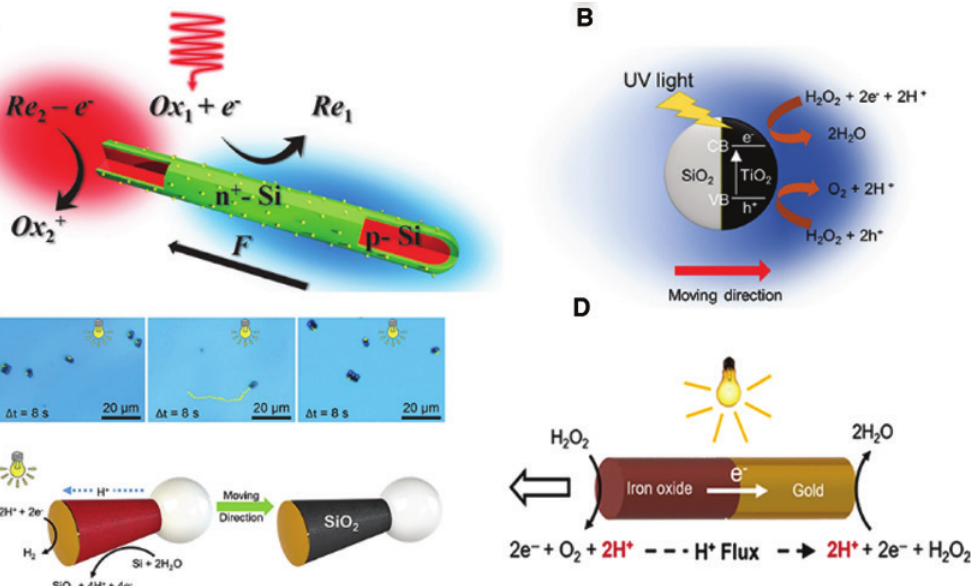
Figure 5: Micro/nanomotors with self-electrophoretic propulsion. (A) Working principle schematic of n + -Si/p-Si micromotor decorated with Pt nanoparticles [93]. Copyright 2017, Wiley-VCH. (B) Schematic of the working mechanism of SiO Copyright 2017, Wiley-VCH. (C) Motion snapshots and the propulsion mechanism of Si/Au micromotor [75]. Copyright 2017, The Royal Society of Chemistry. (D) Schematic of the Fe Royal Society of